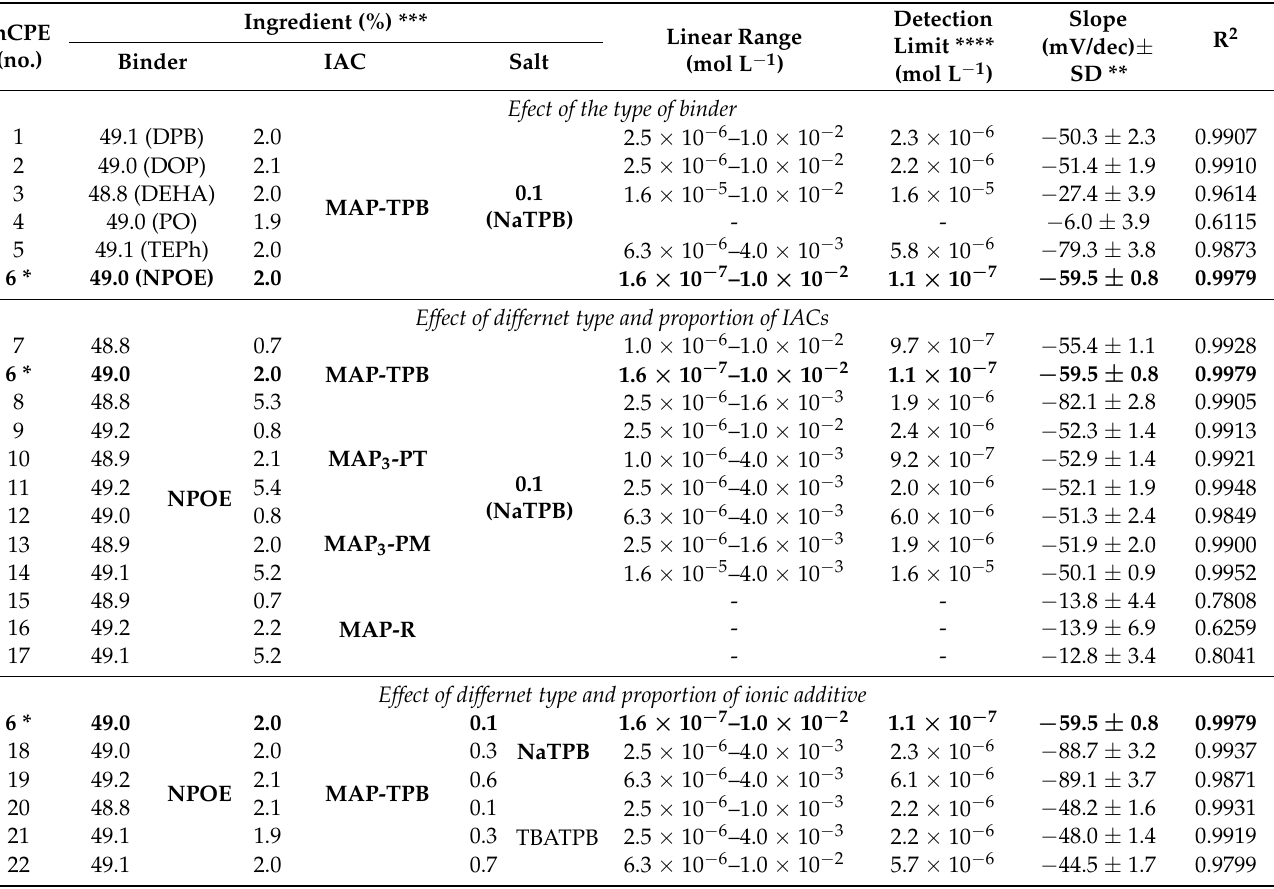
Table 2. The response characteristics of prepared CPEs for potentiometric determination of